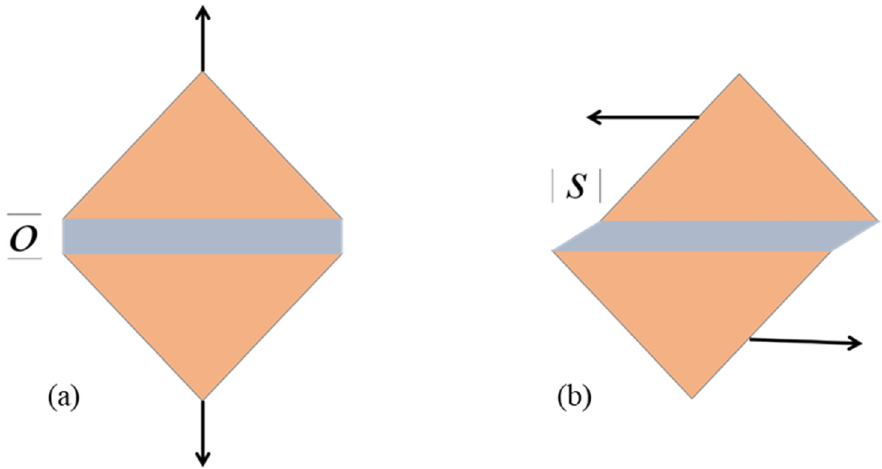
Figure 3. ( a ) Opening of the joint element and ( b ) sliding off the tangential